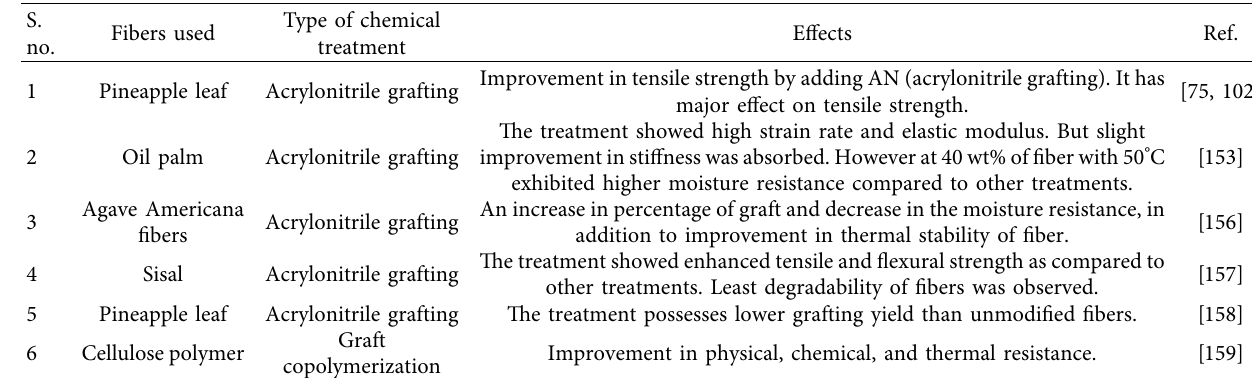
Table 8: Effect of acrylonitrile grafting treatment on various